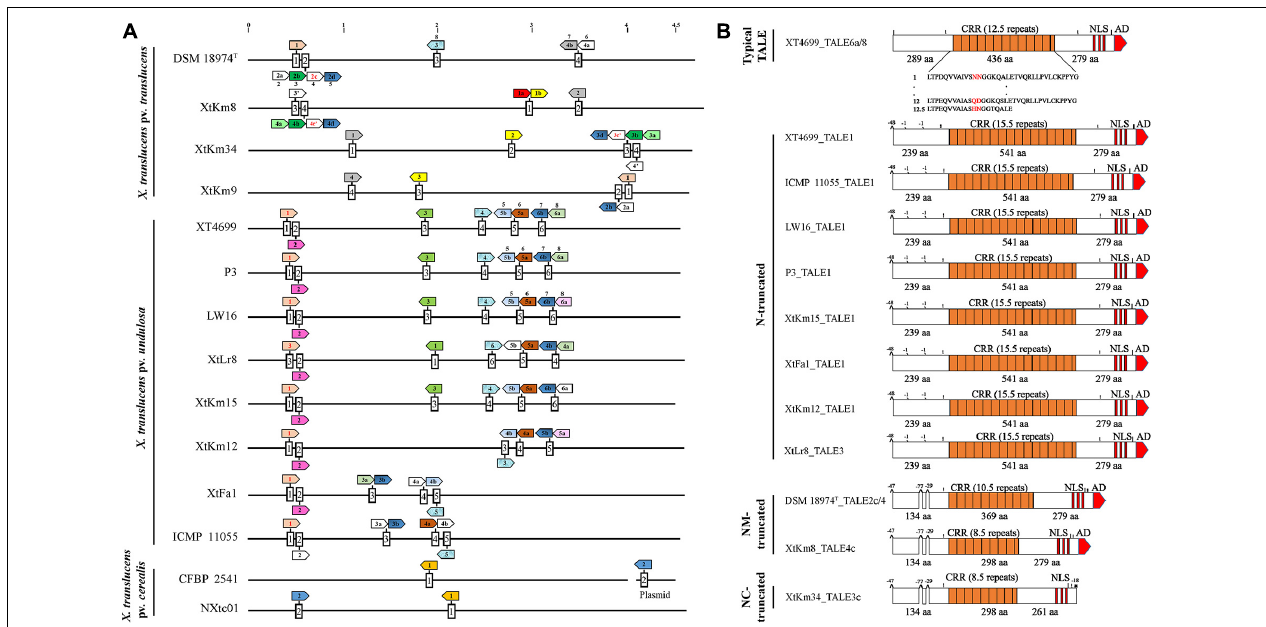
FIGURE 6 | TALE (transcription activator-like effector) repertories of the seven Xanthomonas translucens strains sequenced in this study in comparison to the seven reference sequences obtained from the NCBI GenBank. (A) A linearized plot of the chromosomes of 14 genomes starting from DNA gyrase subunit B ( gyrB ) gene to indicate the distribution and localization of TALE genes in each strain. Each box represents a TALE locus where TALEs that had identity at the 12th and 13th codons (Zero to three RVDs difference) are indicated by colored arrows while pseudogenes are indicated by red fonts inside the arrows. Names of the previously characterized TALEs are indicated above the corresponding arrow. TALEs having RVDs ≤ 9 are indicated by an apostrophe. The remaining TALEs ( ≥ four RVD differences), unique to each strain are not colored. Scale at top of chromosomes in MB. (B) Schematic maps of truncated tal genes where Xtu 4699_TALE6a/8 was used as a reference gene at top. All other TALEs have short N-terminus while XtKm34_TALE3c have deletion of amino acids (aa) both at N- and C-termini. The number of RVDs in each TALE is specified. Symbols shown above the TALE horizontal line (|) Bam HI site (!) Sph I site, ˆ deletion of 29 to 77 aa at start and middle of N-termini, (cid:48) means deletion of single aa and * denote missing activation domain at the said position comparing with reference TALE. Length of CRR, N- and C- termini are displayed in